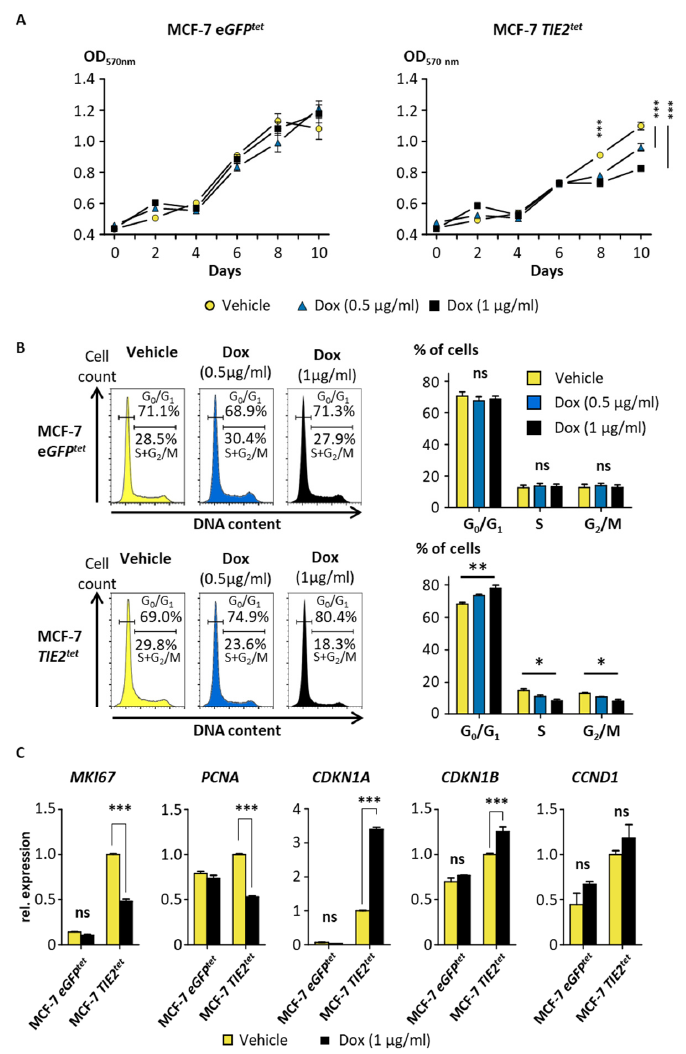
Figure 5. TIE2 expression reduces the proliferation of MCF-7 cells. ( A ) MCF-7 TIE2 tet and MCF-7 eGFP tet cells were cultured in the presence or absence of doxycycline (Dox, 0.5-1 µ g / mL). Proliferation was assessed by MTT. Values are represented as the average ± SEM. *** p < 0.001 vs. vehicle-treated cells using a two-way ANOVA with Bonferroni post-test. ( B ) Representative histograms of a cell cycle analysis of MCF-7 eGFP tet and MCF-7 TIE2 tet cells cultured in the presence or absence of Dox (0.5-1 µg/mL) for 9 days. Percentages of non-proliferating (G 0 /G 1 ) and proliferating (S + G 2 /M) cells are indicated. Average percentages of cells in G 0 /G 1 , S, and G 2 /M ± SEM of three independent cell cycle analyses. ( C ) Expression of M KI67 , PCNA , CDKN1A , CDKN1B , and cyclin D1 ( CCND1 ) in MCF-7 TIE2 tet or eGFP tet cells cultured ±Dox (1µg/mL) for 9 days. Results are represented as the average gene